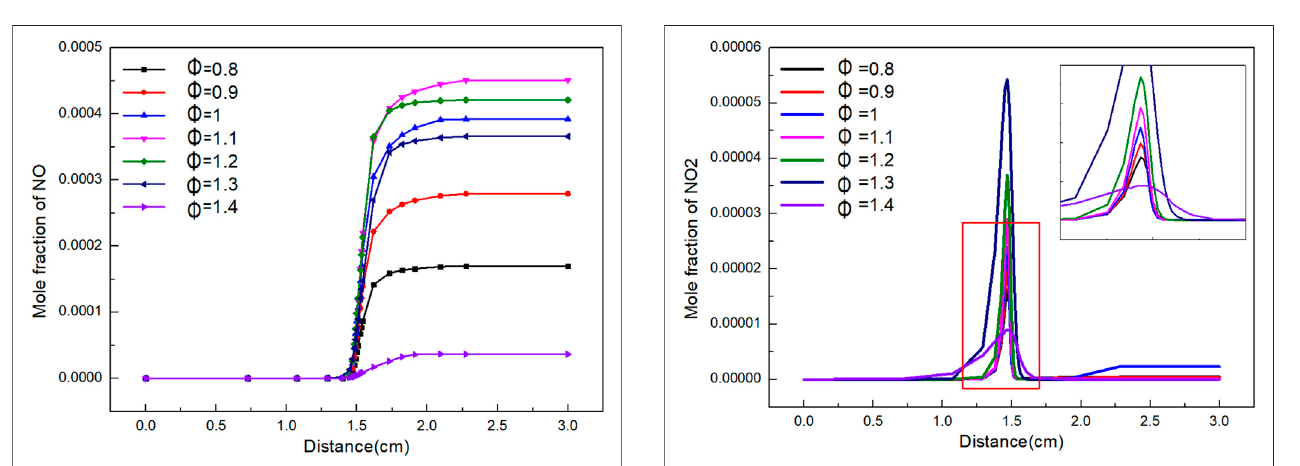
FIGURE 10 | The variation of NO 2 mole fraction with distance under different Φ .